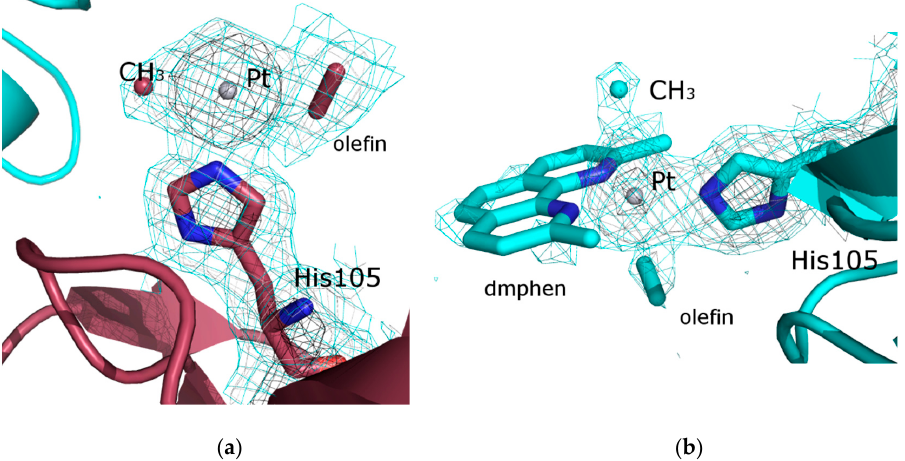
Figure 5. Details of the binding sites of complex I fragments in molecules A ( a ) and B ( b ) of the RNase A adduct. Binding of complex I fragments to RNase A is associated with the loss of Pt ligands, but the scarce definition of the electron density maps does not allow for an undoubtful assignment to be made. 2Fo–Fc electron density maps are contoured at 3 σ (black), 1 σ (grey), and 0.5 σ (cyan) level. 2Fo–Fc electron density map of the binding site of molecule B is contoured at 0.3 σ level in Figure S3.